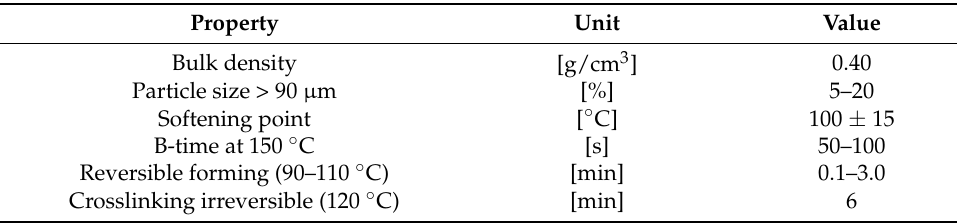
Table A3. Basic values of powder binder: Hexion Epikote Resin TRAC